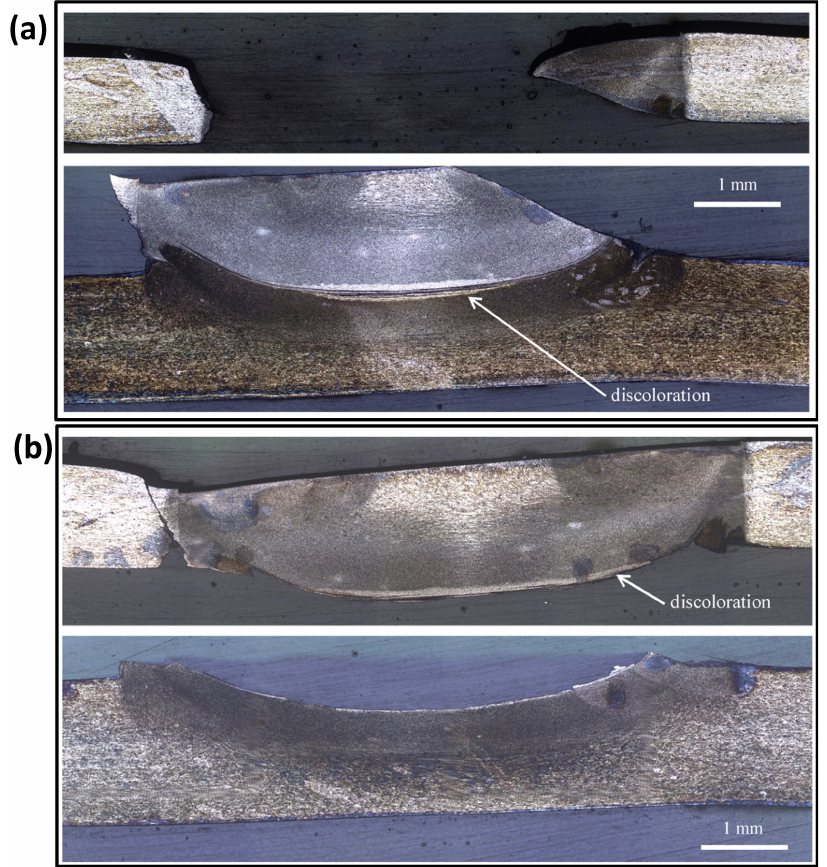
Figure 11 . Failure mode of the RFSSWed AA2024-T3 and AA7075-T6. ( a ) Cross-Section of nugget pullout failure: top sheet cross-section ( top ) and bottom sheet cross-section ( bottom ). ( b ) Cross-Section of interfacial failure: top sheet cross-section ( top ) and bottom sheet cross-section ( bottom ). The cross-section plane is parallel to the pull direction [47] (has permission from Elsevier) .